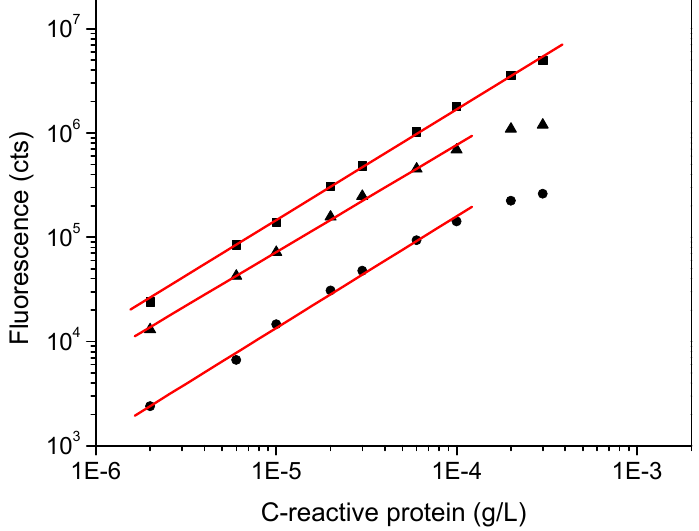
Figure 5. Calibration curves of two-site heterogeneous C-reactive protein immunoassay. C-reactive protein was detected using commercial CdSe/ZnS-labeled (short- ( ● ) and long-lived ( ▲ ) fluorescence) and Eu(III)-labeled ( ■ )